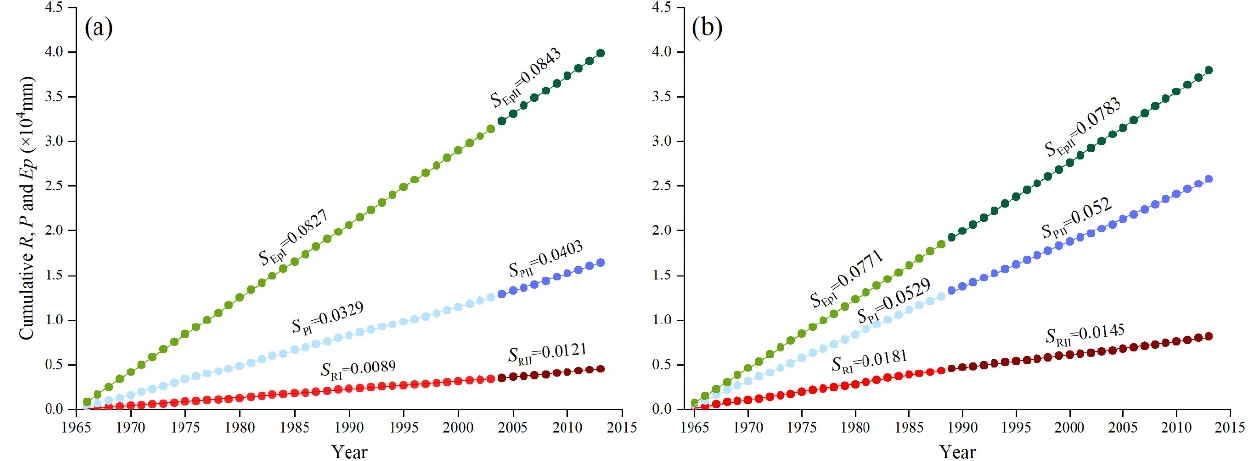
Figure 8. Cumulative curves of annual runoff, precipitation, and potential evapotranspiration for the SRYZ ( a ) and SRYR ( b ). Table 3. Multi-year elastic coefficient of runoff on various impact factors in the SRYZ and SRYR. Region